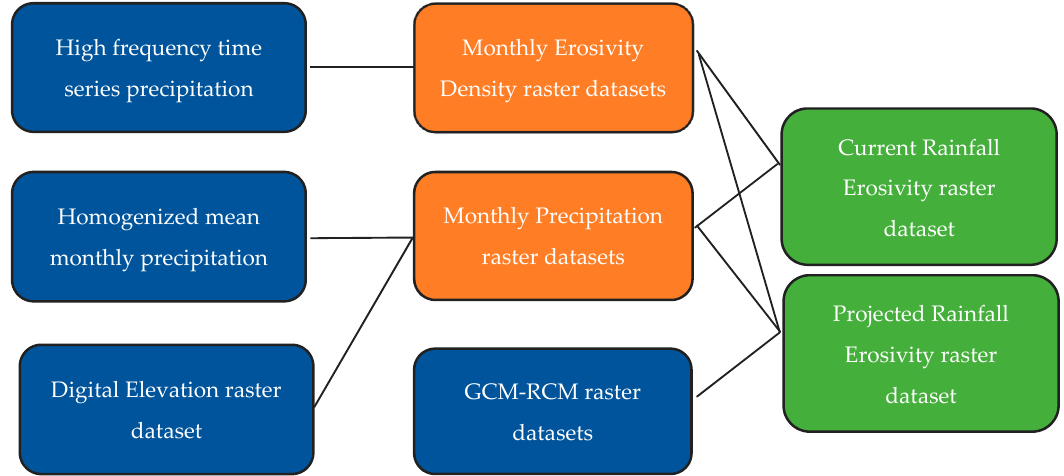
Figure 1. Flowchart of the applied methodology.